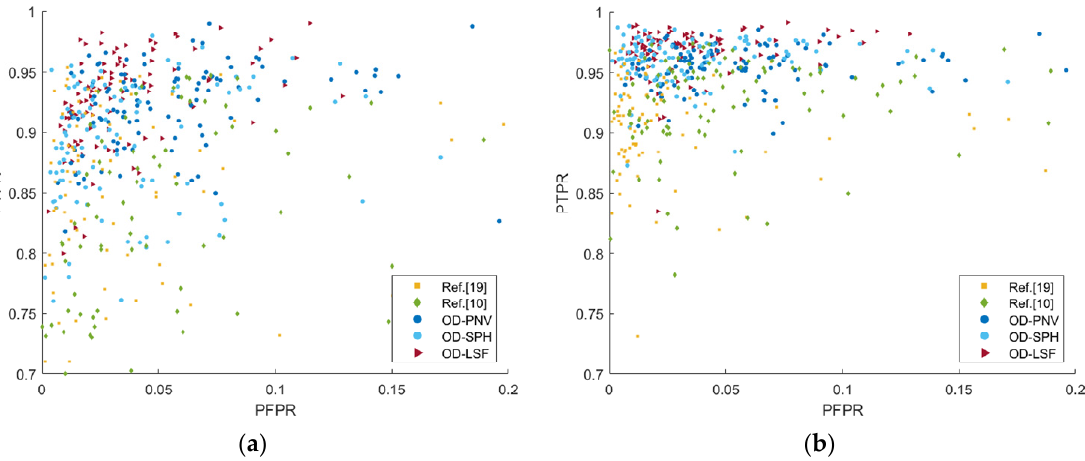
Figure 13. PTPR over PFPR scatter plots: ( a ) Key obstacle subclass; ( b ) Complete obstacle class.